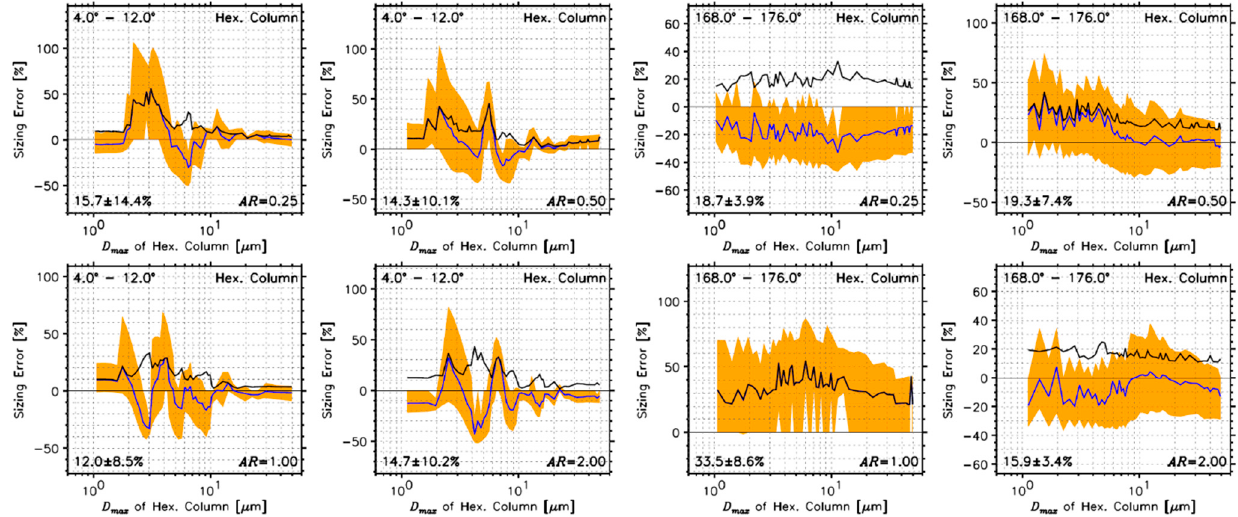
Figure 10. Determined sizing errors of hexagonal ice crystals in forward (4°–12°, left two columns ) and backward (168°–176°, right two columns ) directions. The sizing errors are calculated using an exact comparison between the measured D max of hexagonal ice crystals and those calculated by the ADDA assuming hexagonal ice crystals. Each panel represents a different aspect ratio of a hexagonal ice crystal. The color scheme is the same as Figure 6.